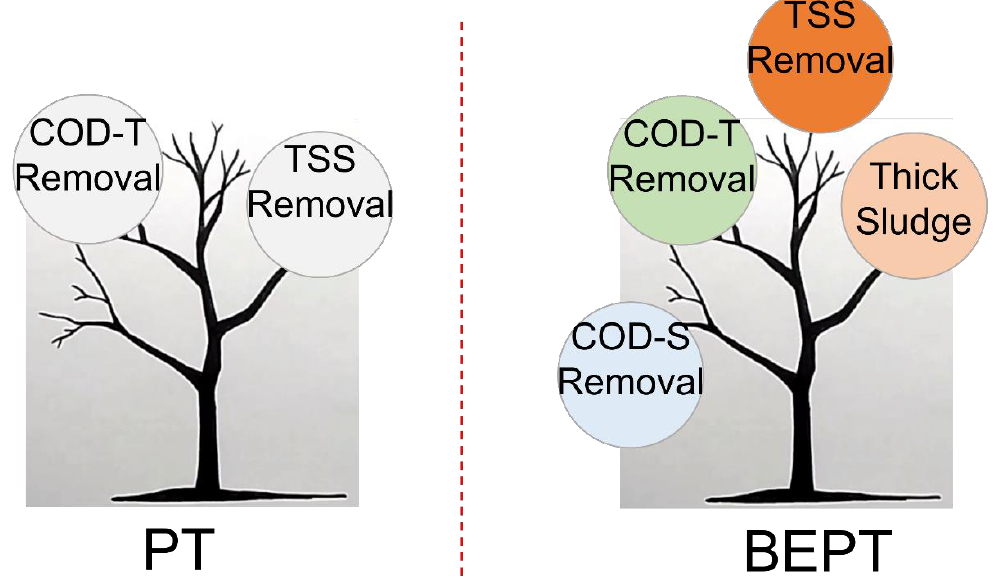
Figure 5. Schematic comparison between conventional PT and BEPT processes in primary treatment of wastewater.